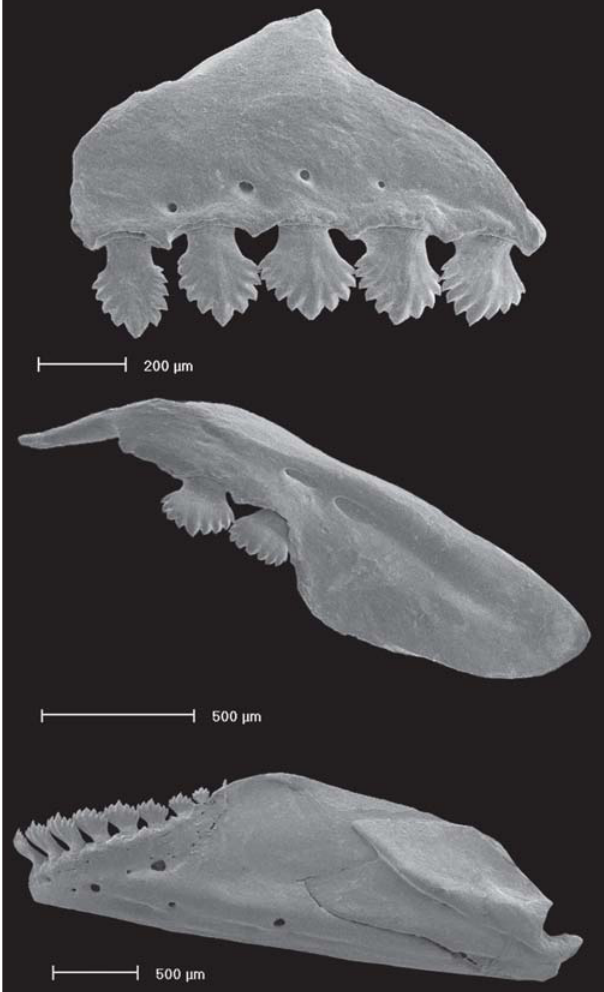
Fig. 2. Dentition of Odontostilbe fugitiva , ANSP 178908, fe- male 35.5 mm SL. SEM photograph of left side premaxilla (top), maxilla (middle), and dentary